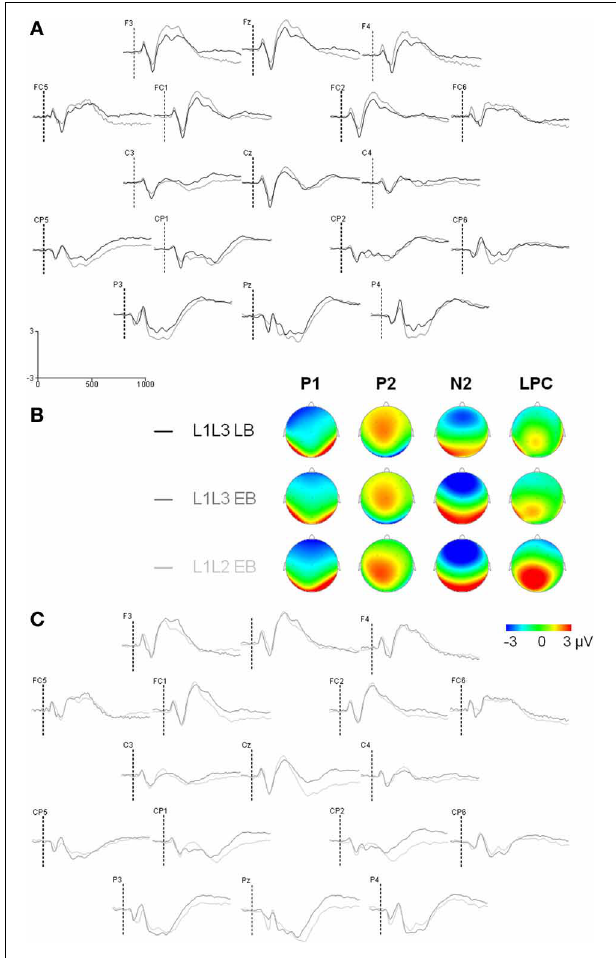
FIGURE 2 | Event-related potentials (Y axis: Mean amplitude in µ V) from the trial presentation (time 0) to 1000ms. (A) ERPs elicited by the presentation of a picture, for L1L3 LB group (black waves) and L1L3 EB group (dark gray waves) over the scalp (17 electrode sites). (B) Topographic maps for the four main ERP components (P1: 90ms, P2: 160ms, N2: 290ms, LPC: 490ms) for L1L3 LB, L1L3 EB and L1L2 EB groups. Color scale ranges from − 3 to 3 µ V, except for P1 component for which it ranges from − 2 to 2 µ V. (C) ERPs elicited by the presentation of a picture, for L1L3 EB group (dark gray waves) and L1L2 EB group (light gray waves) over the scalp (17 electrode